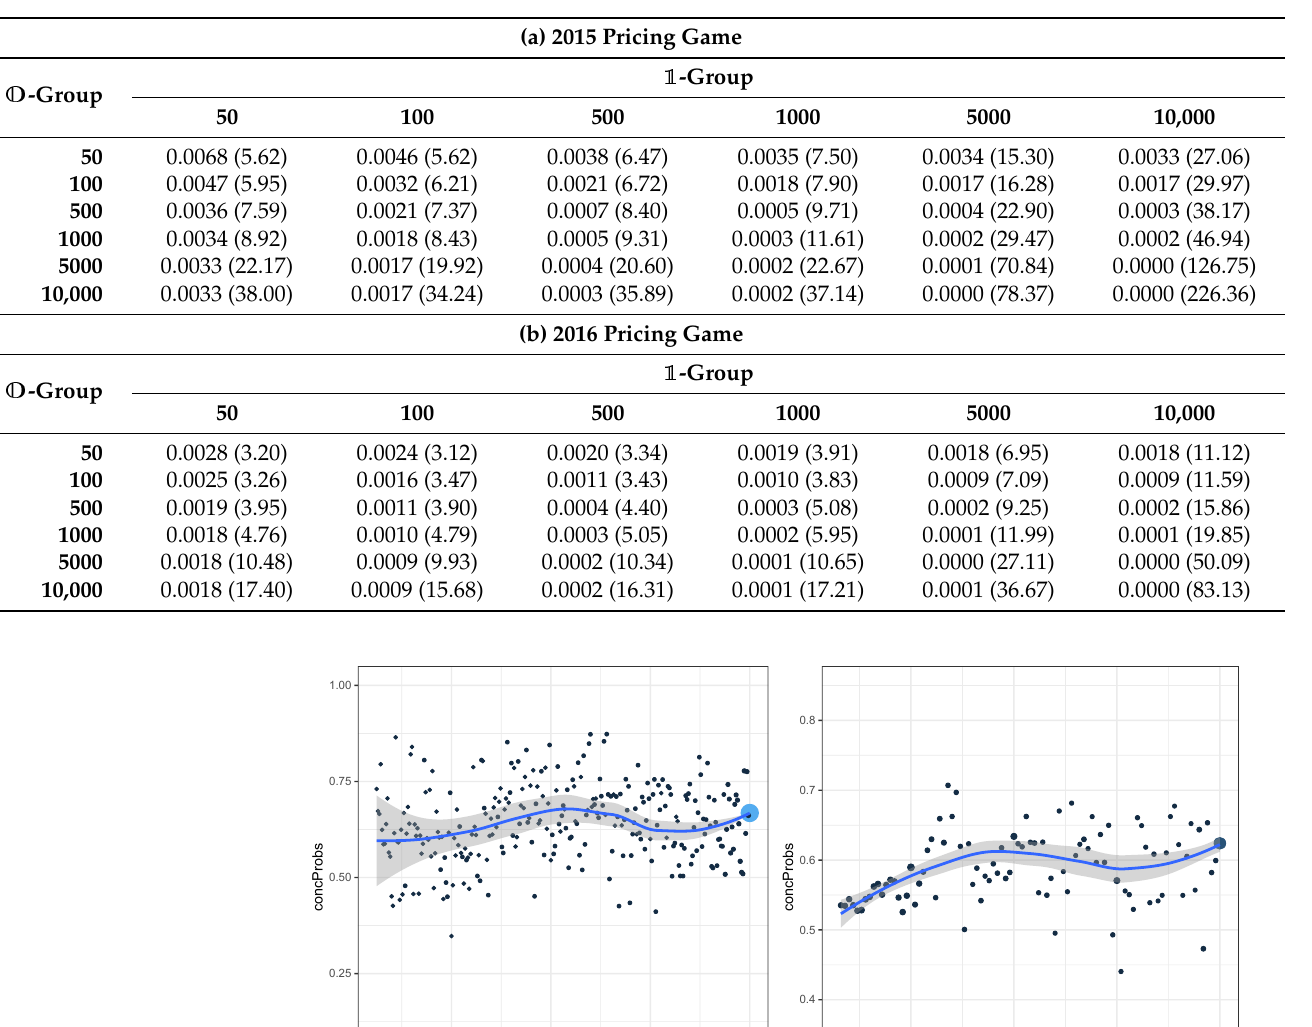
Table A2. Bias and run time (s), the latter between brackets, for the extended marginal approximation of C ≈ 2015 and 2016 pricing game dataset. This is given for the rough grid version and for several different numbers of boundary values for the O - and 1 -group.